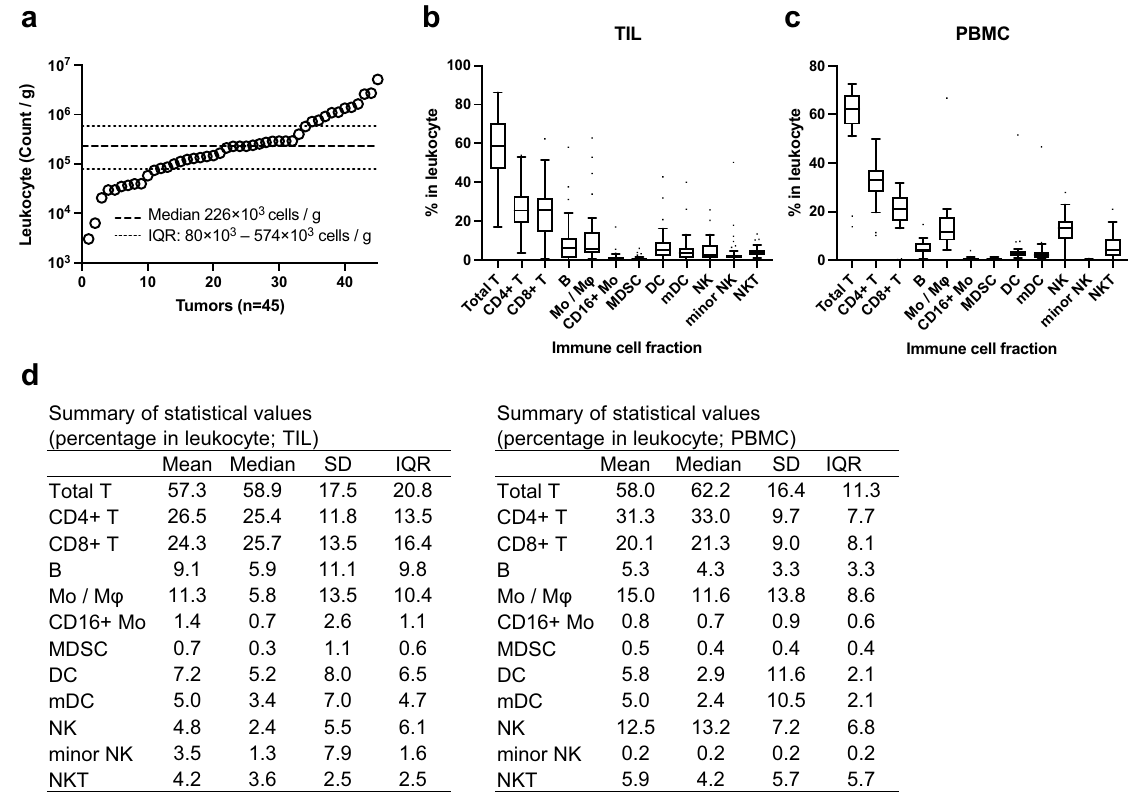
Figure 1. Summary of leukocytes and immune cell fractions distribution determined using flow cytometry (FCM). Tumor and blood samples were assessed using multicolor FCM, and leukocyte and 11 types of immune cell fractions in the samples were analyzed. ( a ) Distribution of leukocyte density (count/g) determined by FCM in 45 breast tumors. The graph shows the medians, 25th percentile, and 75th percentile. ( b , c ) Percentages of each immune cell fraction in tumors (n = 45) and blood samples (n = 18) showed as Tukey box plots. ( d ) Statistical values are summarized for the percentages of each immune cell fraction in the tumor tissues (n =